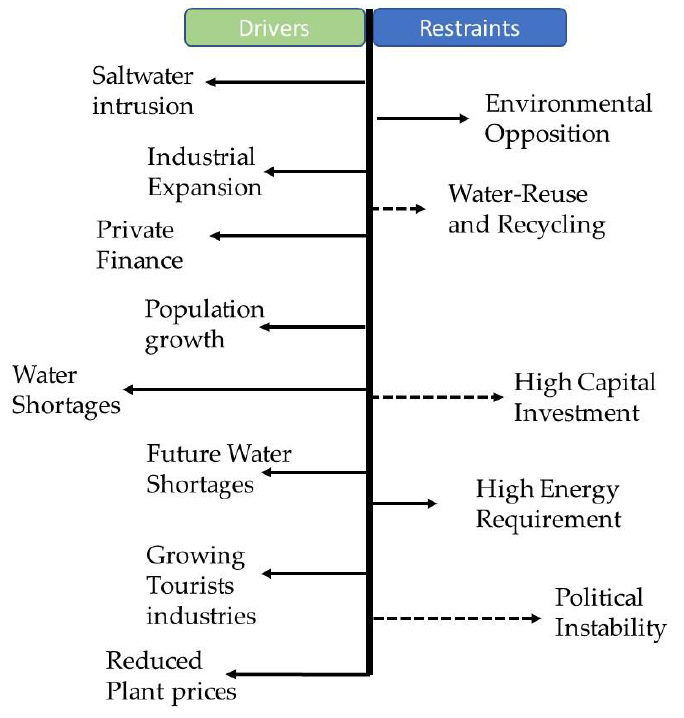
Figure 8. Key desalination market forces [23].